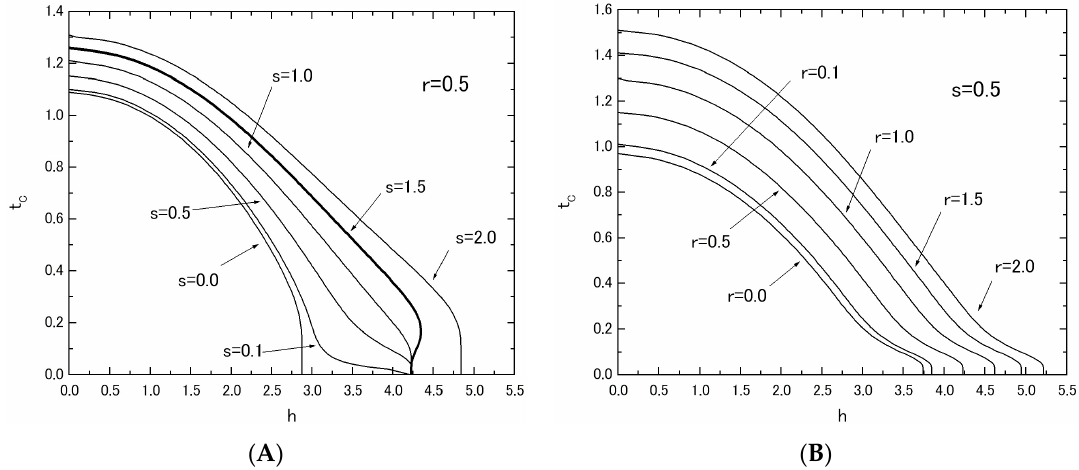
Figure 5. The phase diagrams ( t C versus h plot) for the system B; The value of r is fixed at r = 0 . 5 and the value of s is changed from s = 0 . 0 to s = 2 . 0 ( A ). The value of s is fixed at s = 0 . 5 and the value of r is changed from r = 0 . 0 to r = 2 . 0 ( B ).